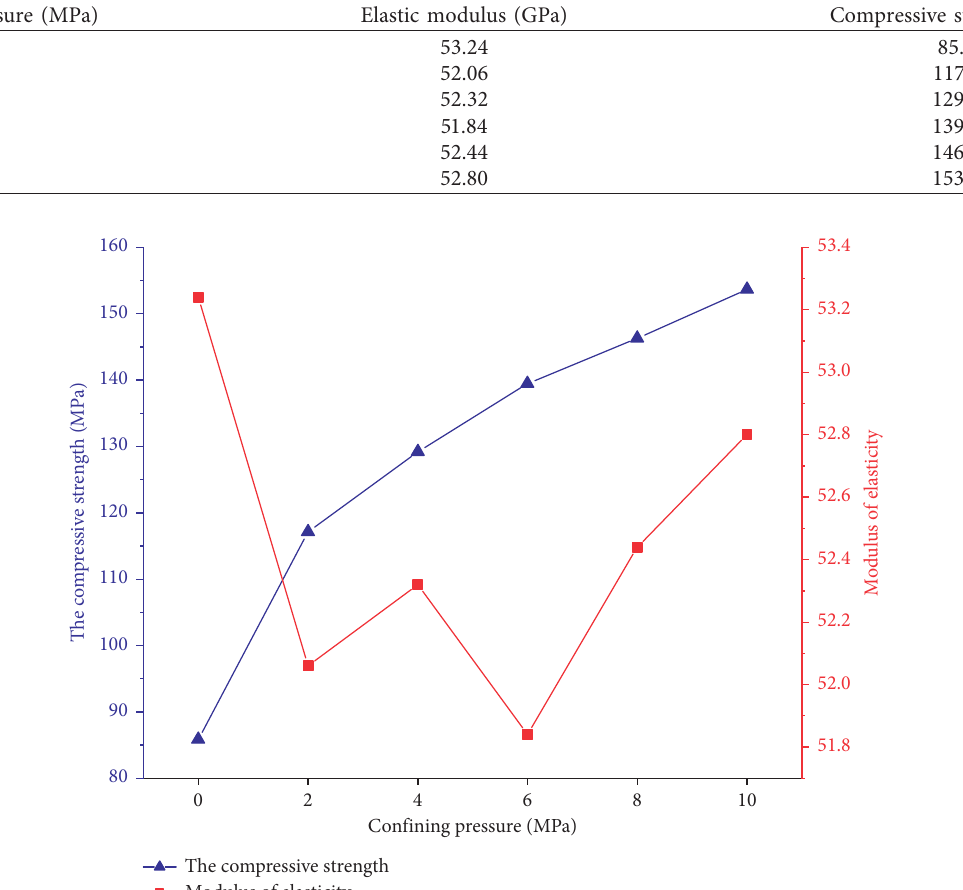
Figure 13: Variation trend of compressive strength and elastic modulus of shale under different confining